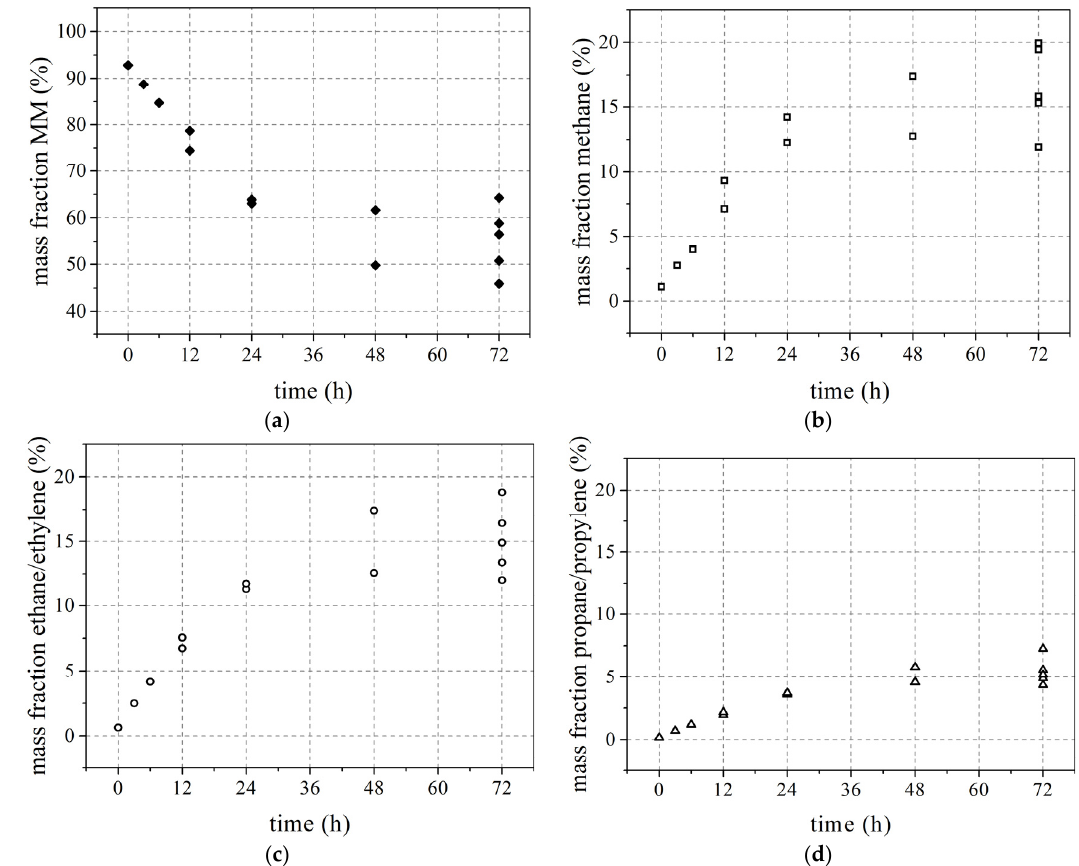
Figure 6. Mass fraction of: ( a ) MM; ( b ) methane; ( c ) ethane/ethylene and; and ( d ) propane/propylene in the vapor phase after the experiment depending on time ( T = 420 °C).